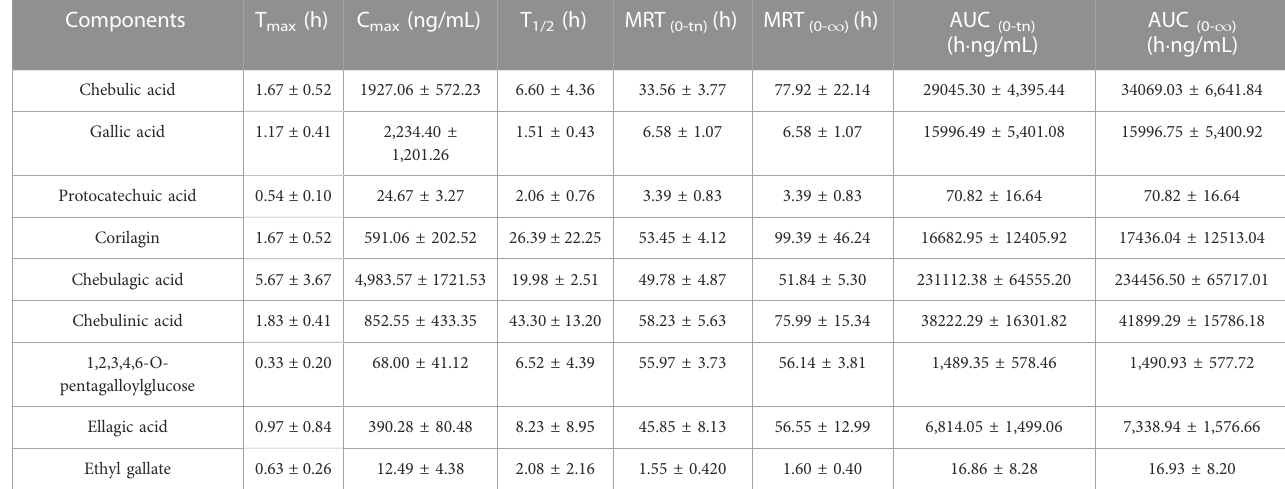
TABLE 7 Pharmacokinetic parameters of nine analytes in normal administration and model administration groups of rats. (Mean ± SD, n = 6).